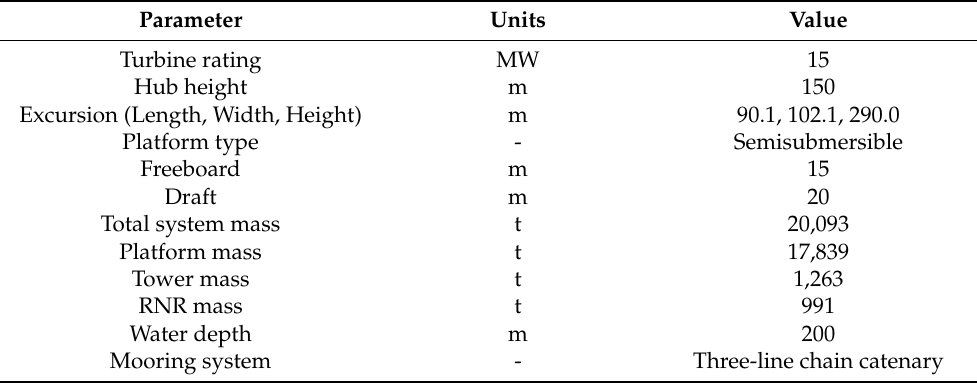
Figure 1. 15 MW floating offshore wind turbine system and reference coordinate system. Table 1. 15 MW floating offshore wind turbine system general properties.